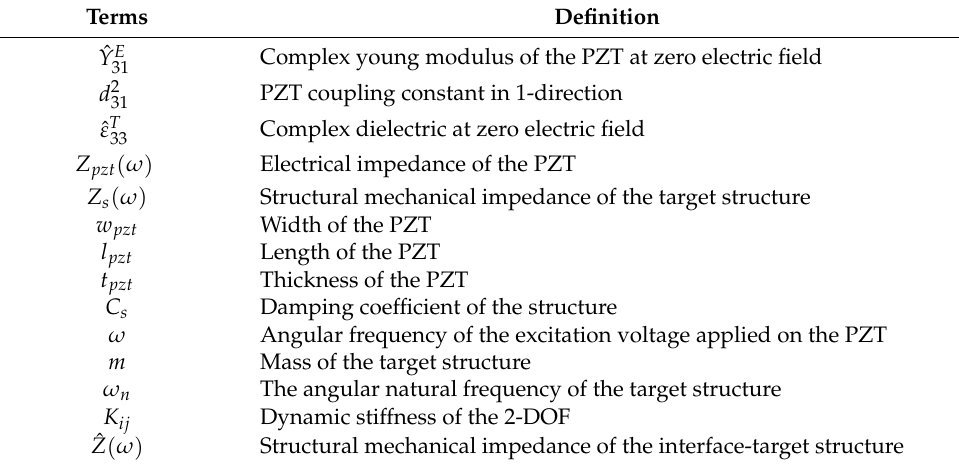
Table 6. Equation terms definition.